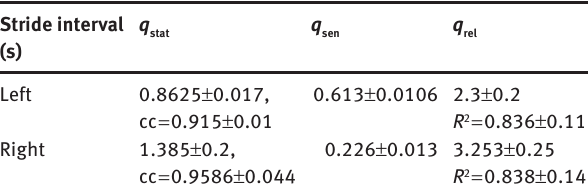
Table 3: Tsallis q -triplet for stride intervals corresponding to a subject with Huntington’s disease (HD).